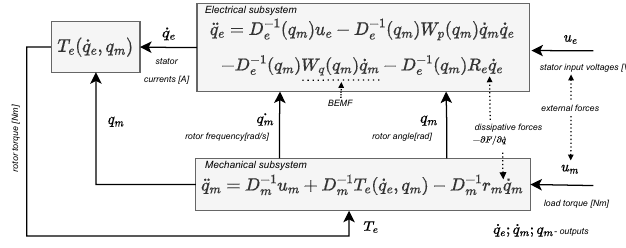
Figure 1. Illustration of the electrical machine